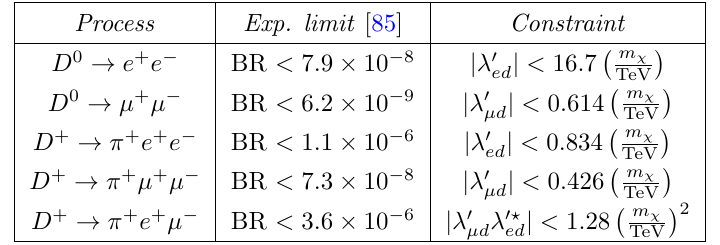
‘ + ‘ (cid:0) and D + (cid:25) + ‘ + ‘ (cid:0) decays. ! !